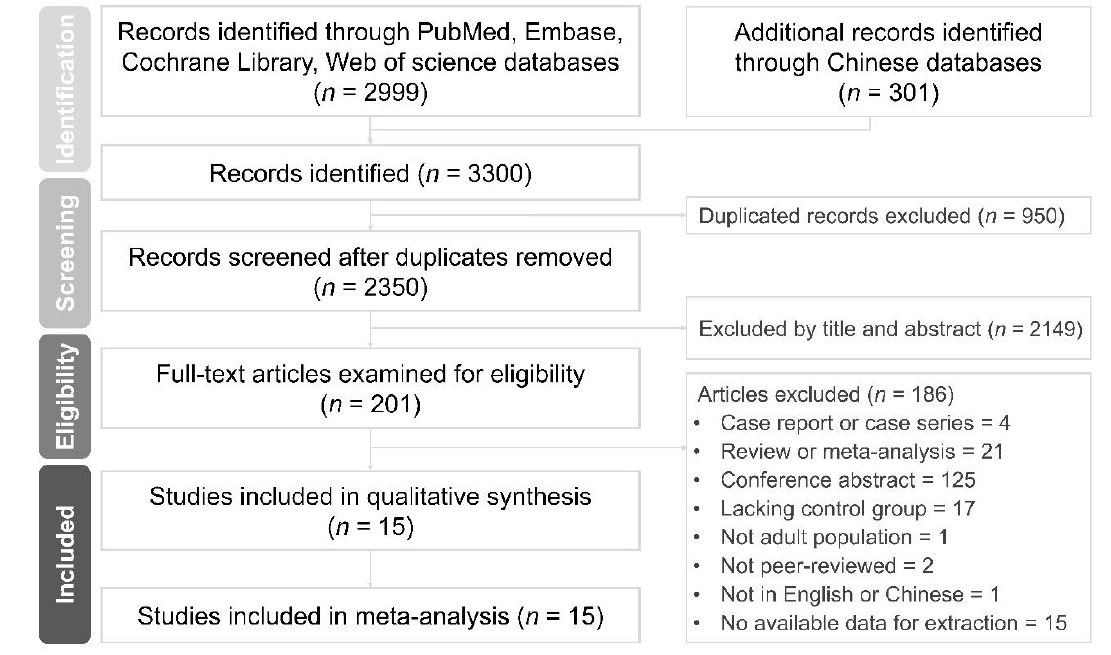
Figure 1. Preferred Reporting Items for Systematic Reviews and Meta-Analyses (PRISMA) flow diagram of the process of screening and including the studies.